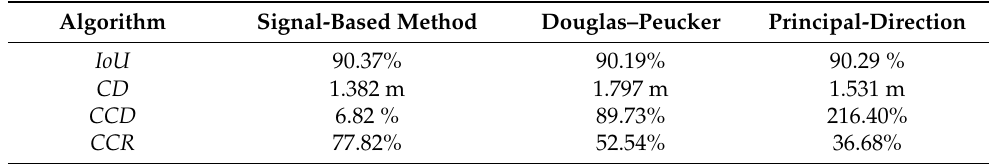
Table 3. Quantitative Analyses (Santa Rosa).